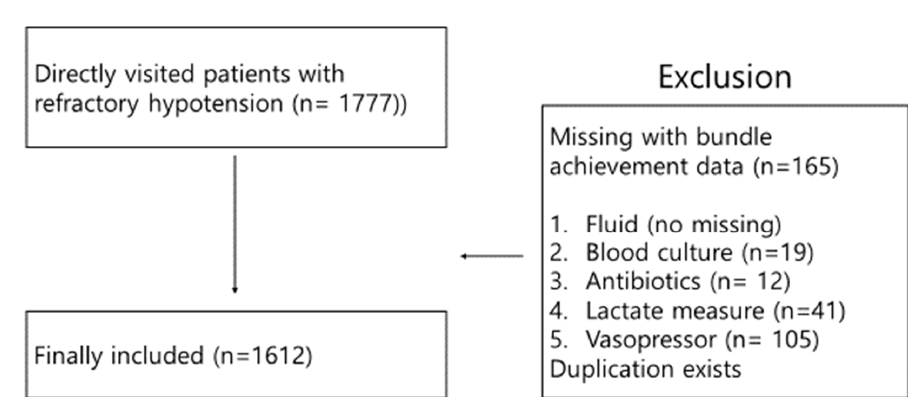
Figure 1. Patient selection flow diagram. Table 1. Comparison of and clinical characteristics of the 3 bundle groups.